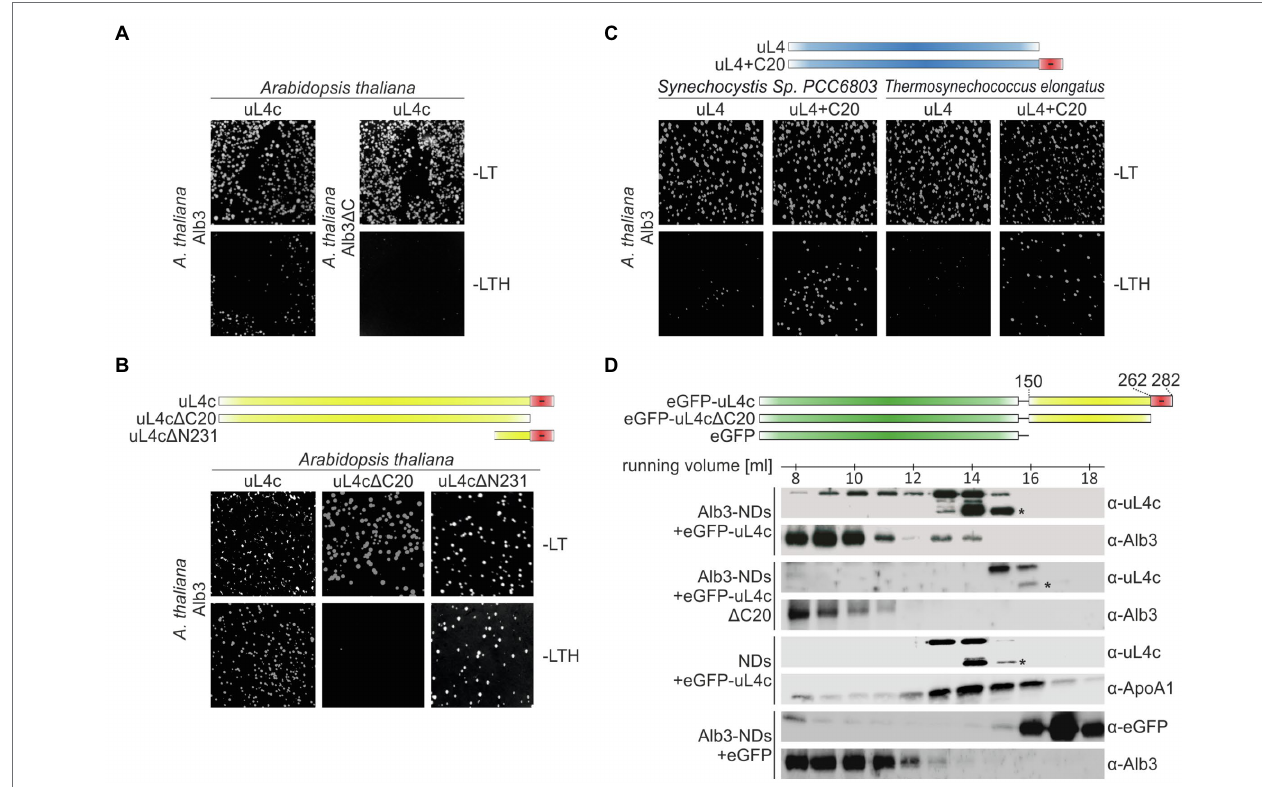
FIGURE 4 | Split ubiquitin and size exclusion chromatography interaction assays between Alb3 and uL4c constructs. Split ubiquitin assays (A–C) were performed employing fusions to the C- (Cub) and N- (NubG) terminal halves of ubiquitin. The Alb3 constructs were C-terminally fused to Cub and the uL4 constructs were N-terminally fused to NubG. Alg5-NubI and Alg5-NubG served as positive and negative controls, respectively. Yeast colonies were plated on permissive medium (-LT) and on selective medium (-LTH). A full version with all control experiments is shown in Supplementary Figure S2 . (A) Comparison between the interaction of mature Alb3 (amino acids 55–462) and C-terminally truncated Alb3 (amino acids 55–369; Alb3 Δ C) with A. thaliana uL4c. (B) Interaction assay between Alb3 and uL4c or uL4c deletion constructs lacking 20 C-terminal amino acids (uL4c Δ C20) or 231 N-terminal amino acids resulting in a construct coding for the last 50 amino acids (uL4c Δ N231). (C) Interaction assay between Alb3 and cyanobacterial uL4 proteins or fusions of cyanobacterial uL4 proteins with the C-terminal 20 amino acids of A. thaliana uL4c (uL4+C20). (D) Size exclusion chromatography assays were performed by incubating Alb3-NDs with fusion constructs of eGFP and the C-terminal half of A. thaliana uL4c with and without its negative C-terminus, eGFP-uL4c (amino acids 150–282) and eGFP-uL4c Δ C20 (amino acids150–262), respectively. Control assays were conducted using Alb3-NDs in combination with eGFP and empty NDs in combination with eGFP-uL4c. The elution fractions between 7.5 and 18.5 ml were analyzed immunologically using antibodies against A. thaliana chloroplast Alb3 ( α -Alb3), A. thaliana chloroplast ribosomal protein uL4c ( α -uL4c), Human Apolipoprotein A1 ( α -ApoA1; the wildtype template of MSP1D1) and eGFP ( α -GFP). Asterisks mark C-terminal degradation bands of the